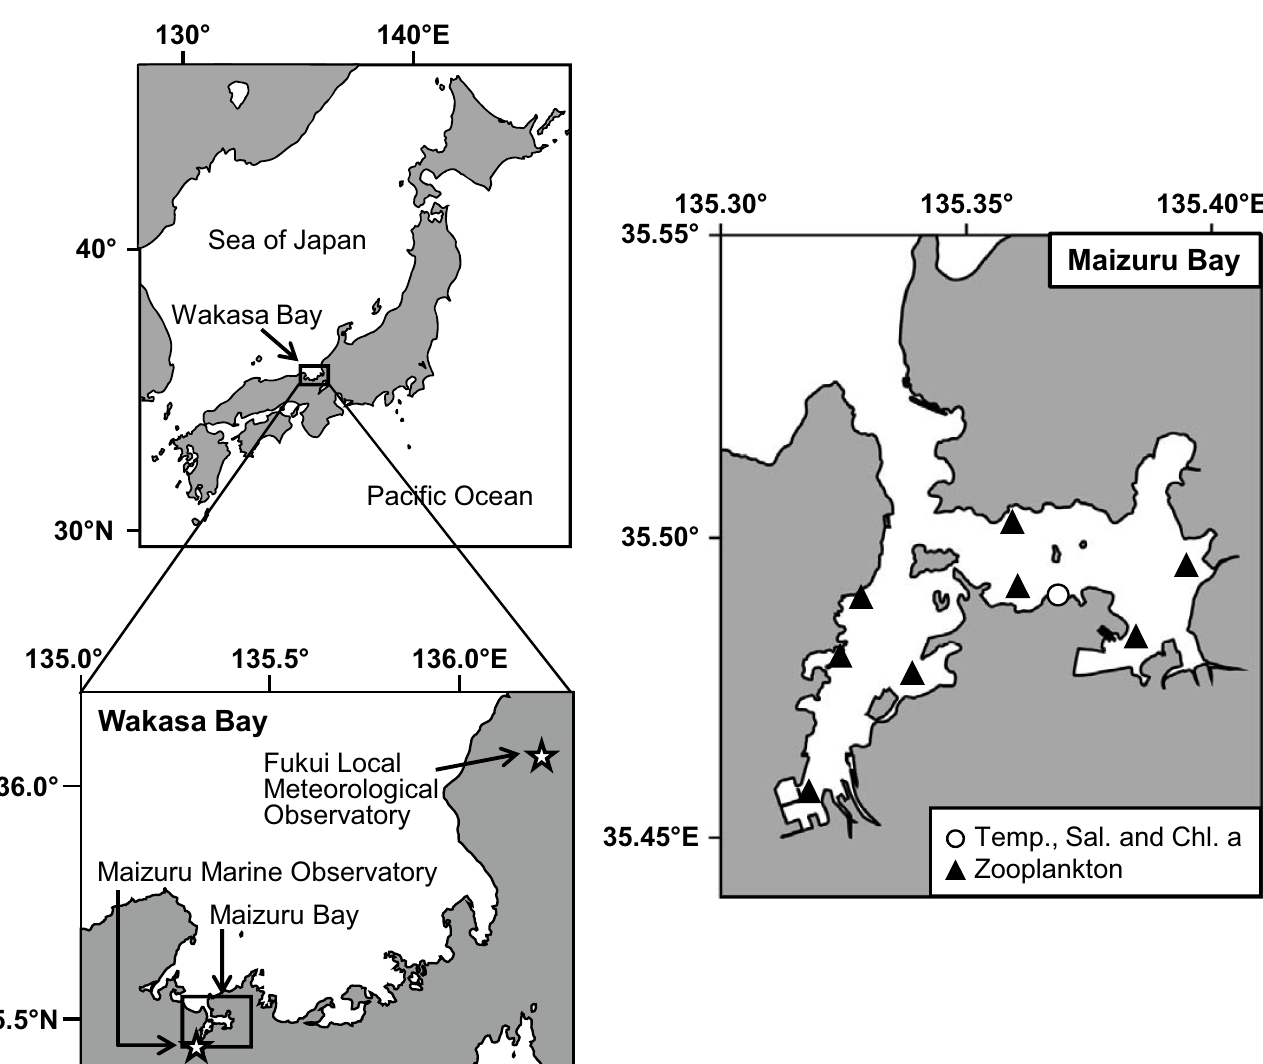
Fig 2. Study area. Stars on the left bottom map indicate observatories from which global horizontal irradiance data were obtained. A circle and black triangles on the right map indicate stations where environmental parameters were